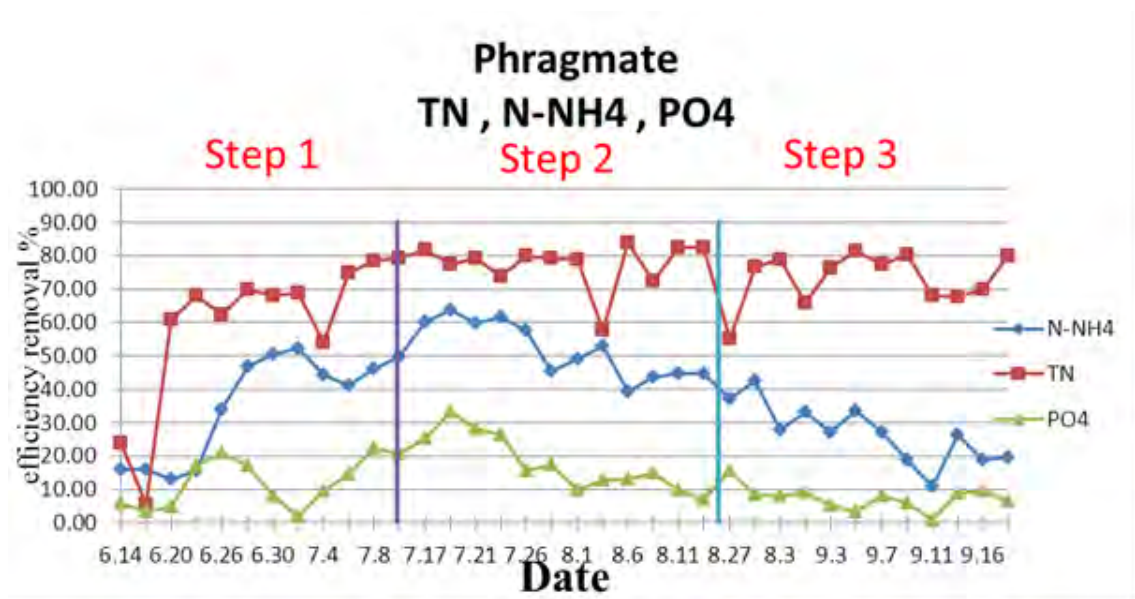
Figure 12. Efficiency removal of TN,N-NH 4 ,PO 4 IN Phragmate tanks during three surface loads (8,6,4)m 3 /m 2 .h and tow circulation ratios(10%,20%) for each load and for one week time for each different load .